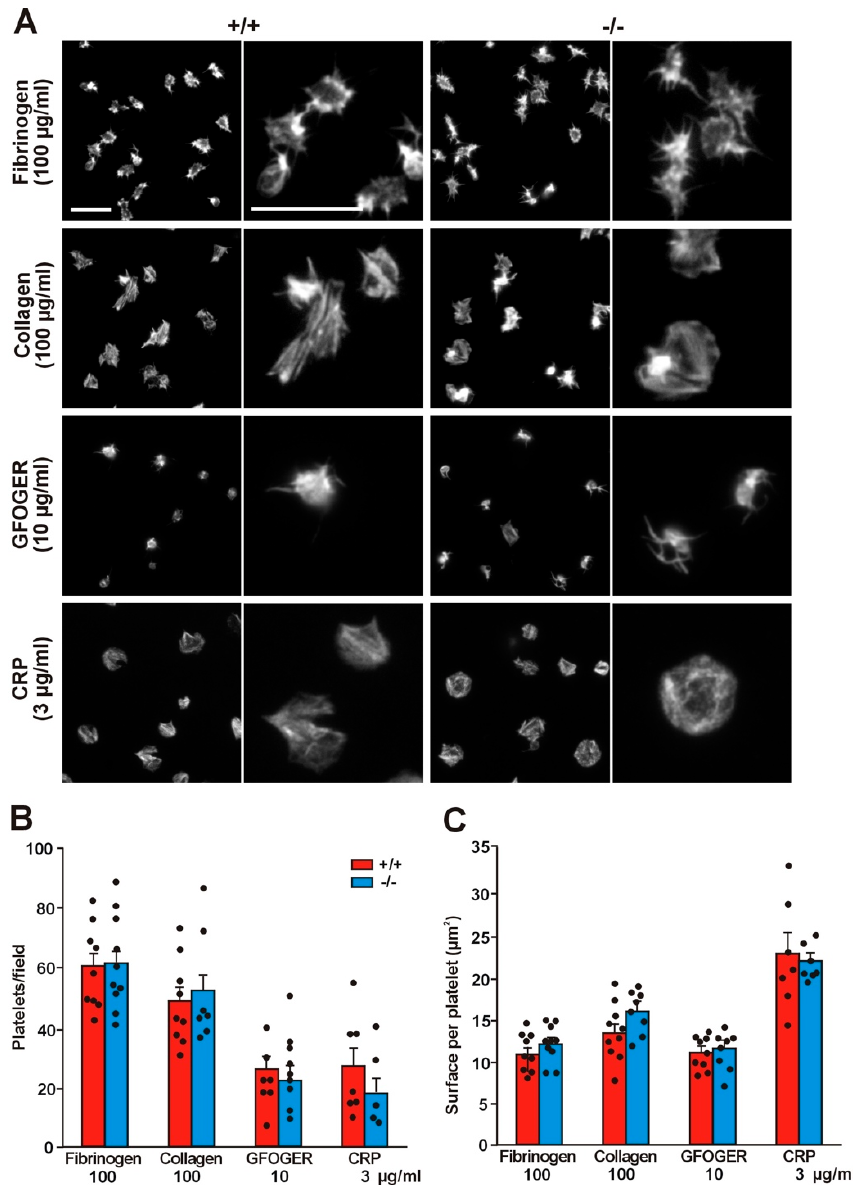
Figure 5. Absence of Coro1 does not impair platelet spreading. ( A ) Adhesion of washed platelets to glass coverslips coated with the indicated concentration of collagen, fibrinogen, Gly-Phe-Hyp-Gly-Glu-Arg (GFOGER), or CRP. Adherent platelets were fixed with 4% PFA, permeabilized with 0.3% Triton X-100, and stained with TRITC-phalloidin. Images were acquired with a fluorescence microscope equipped with a structured illumination attachment and deconvolved. Examples of platelets at two magnifications are shown. Scale bars represent 10 µm; ( B ) Number of platelets adhering to the indicated concentrations of collagen, fibrinogen, GFOGER, or CRP. 5 fields each 12,500 µm 2 from 5–10 independent experiments were scored per condition. Data represent mean ± SEM. No significant differences were found between WT and KO platelets for any